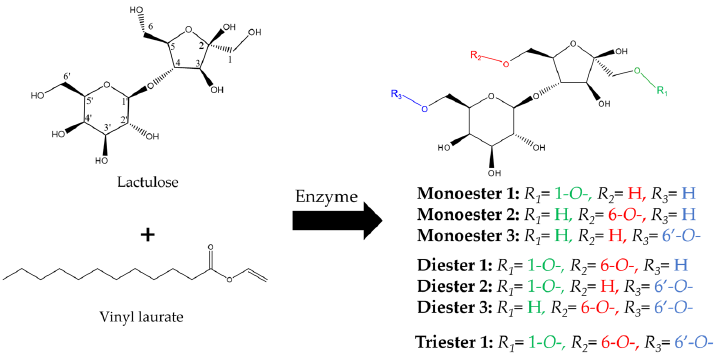
Figure 2. Studied enzymatic reactions. R 1 , R 2 , and R 3 are the acylation positions in lactulose, where each R is a lauryl residue. When the synthesis of monoesters occurs, the acylation positions are 1 ‐ O ‐ , 6 ‐ O ‐ , or 6 ′‐ O ‐ , diester: (1 ‐ O ‐ , 6 ‐ O ‐ ), (1 ‐ O ‐ , 6 ′‐ O ‐ ) , or (6 ‐ O ‐ , 6 ′‐ O ‐ ), and triester: (1 ‐ O ‐ , 6 ‐ O ‐ , 6 ′‐ O ‐ ). Ten biocatalysts were used for the transesterification reaction screening, and they are shown in Figure 3a,b. Candida antarctica lipase B immobilized in acrylic resin (Novozym 435), Mucor miehei lipase immobilized on a macroporus ion ‐ exchange resin (Lipozyme ® ) , Thermomyces lanuginosus lipase immobilized as silica granulated (Lipozyme ® TL IM), and Alcaligenes sp. lipase immobilized in granulated diatomaceous earth (QLG) s howed activity and different products were observed. The monoesters produced with Lipozyme TL IM, Lipozyme, and QLG have the same retention factor ( R f = 0.289), while with Novozym 435 the R f is 0.235.